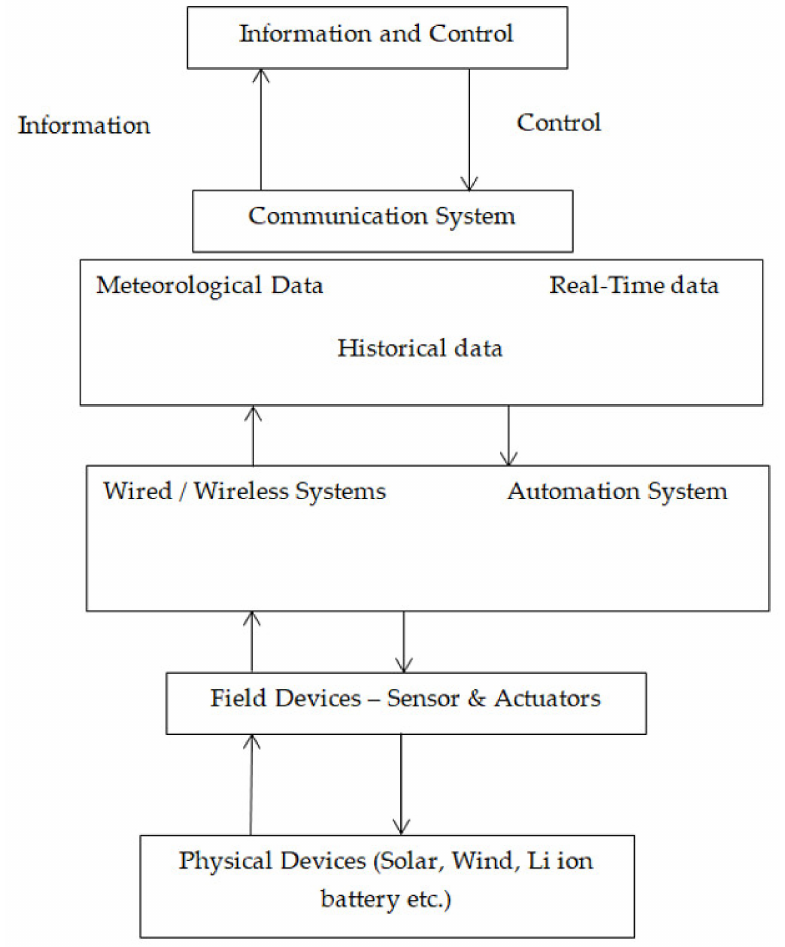
Figure 6. Typical smart microgrid with cyber secure